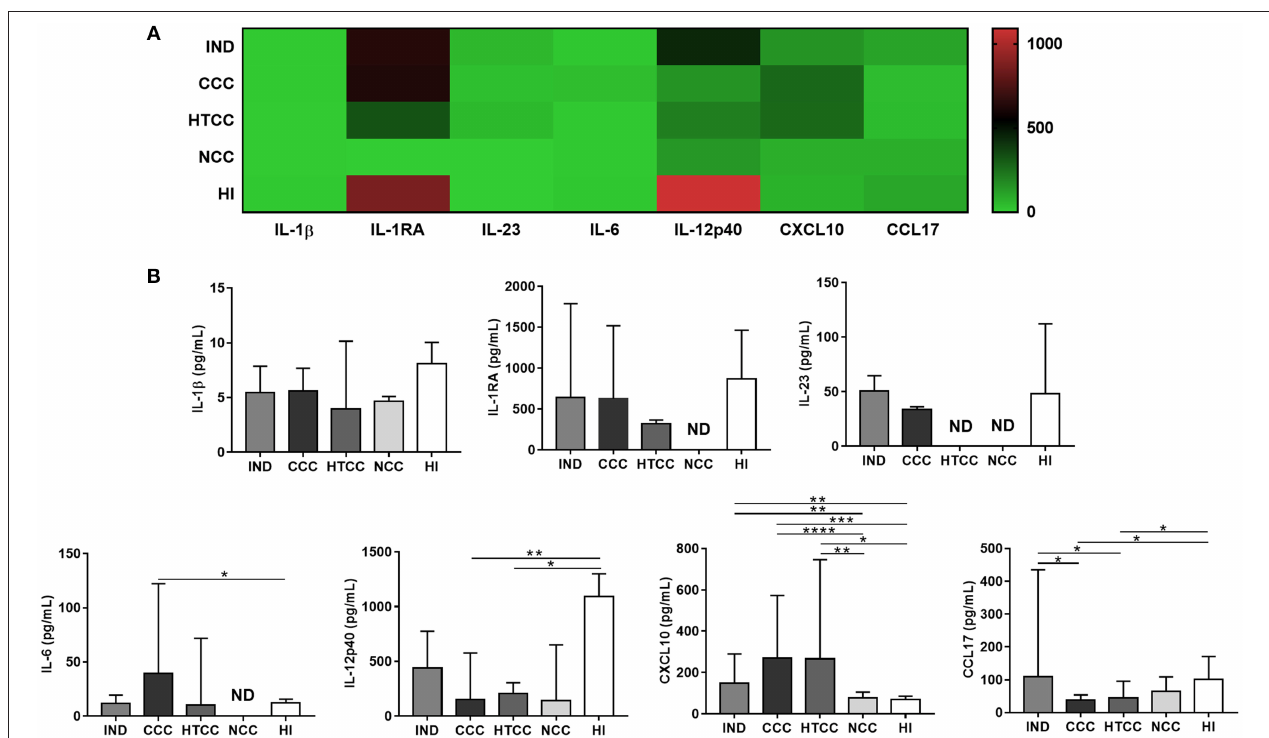
FIGURE 3 | Cytokines and chemokines concentration in plasma from donors of all groups. Heat map that shows the patterns of cytokines and chemokines concentration in chagasic patients (IND, CCC, and HTCC) and controls (NCC and HI) are distinct (A) . Comparison of IL-1 β , IL-1RA, IL-6, IL-12p40, IL-23, CXCL10, and CCL17 levels was done with Mann-Whitney test. The median and interquartile ranges of cytokines are displayed (B) . ND, Not detectable. Differences are indicated as follows: * p < 0.05, ** p < 0.01, *** p < 0.001, **** p <